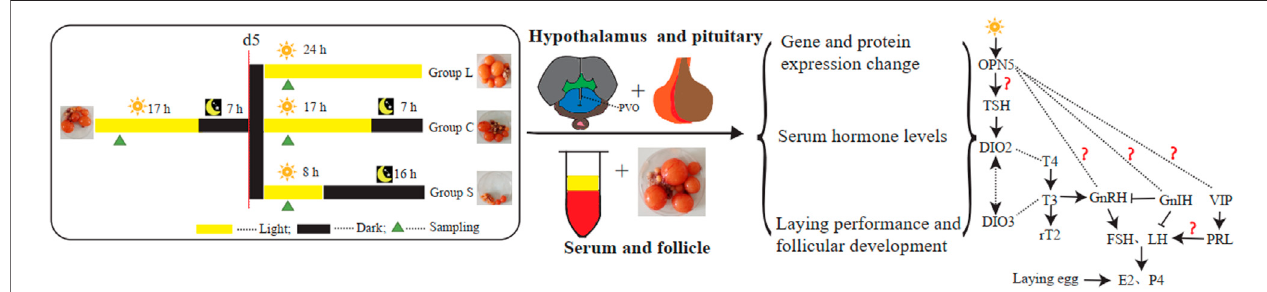
FIGURE 1 | Experimental design All mountain ducks were randomly divided into three types of group. All samples were collected at d0, d5, d8, d20, d35. Serum samplesinthethreetypesofgroupwerecollectedforanalysisofserumhormonelevels.Hypothalamicandpituitarytissueintheinthethreetypesofgroupwerecollected for related genes and proteins